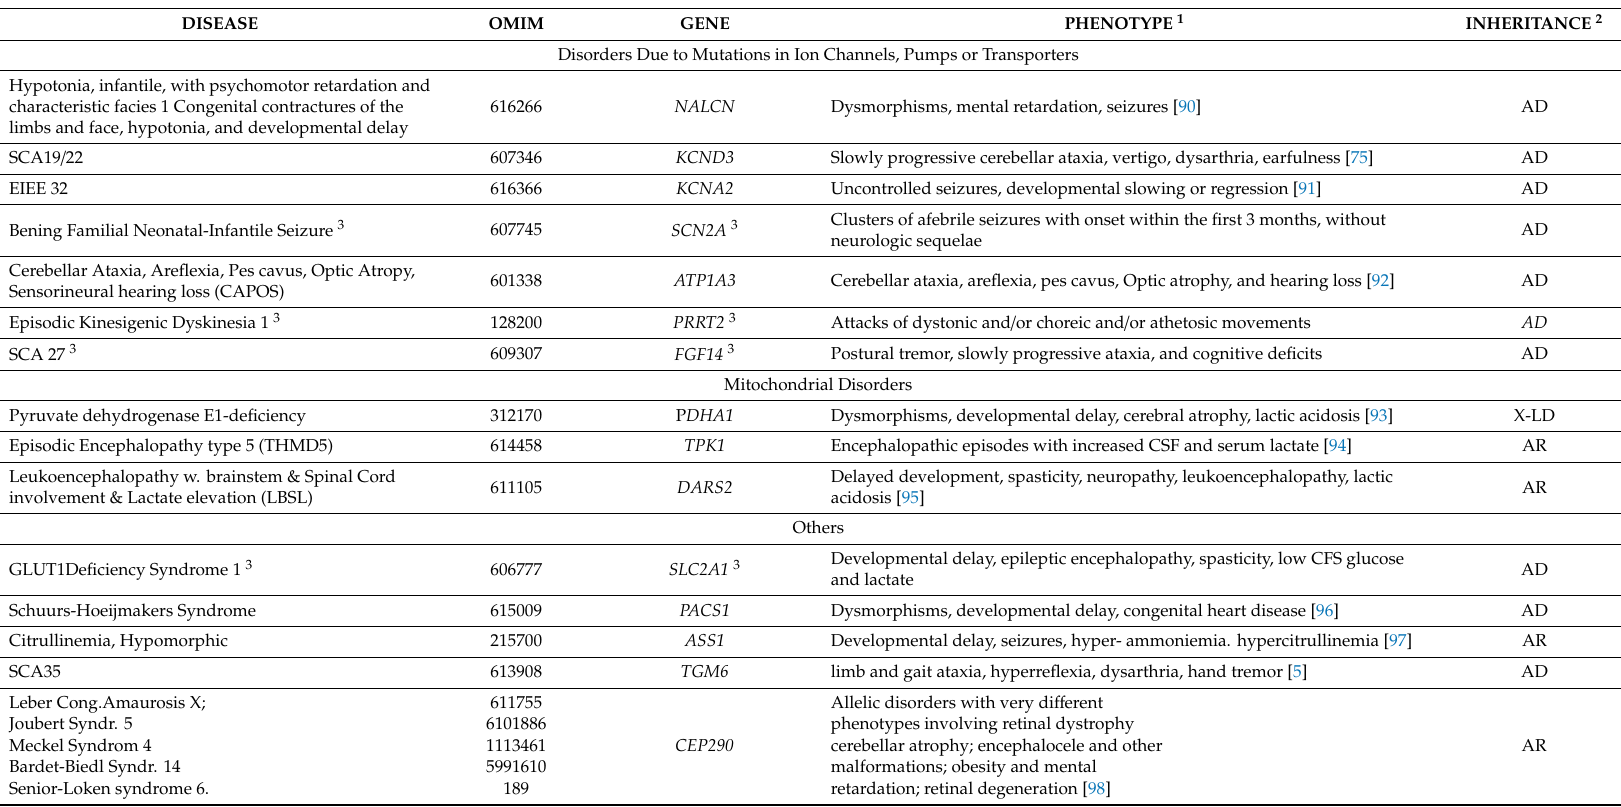
Table 2. List of disorders that can include episodic ataxia as a phenotypic variant of complex